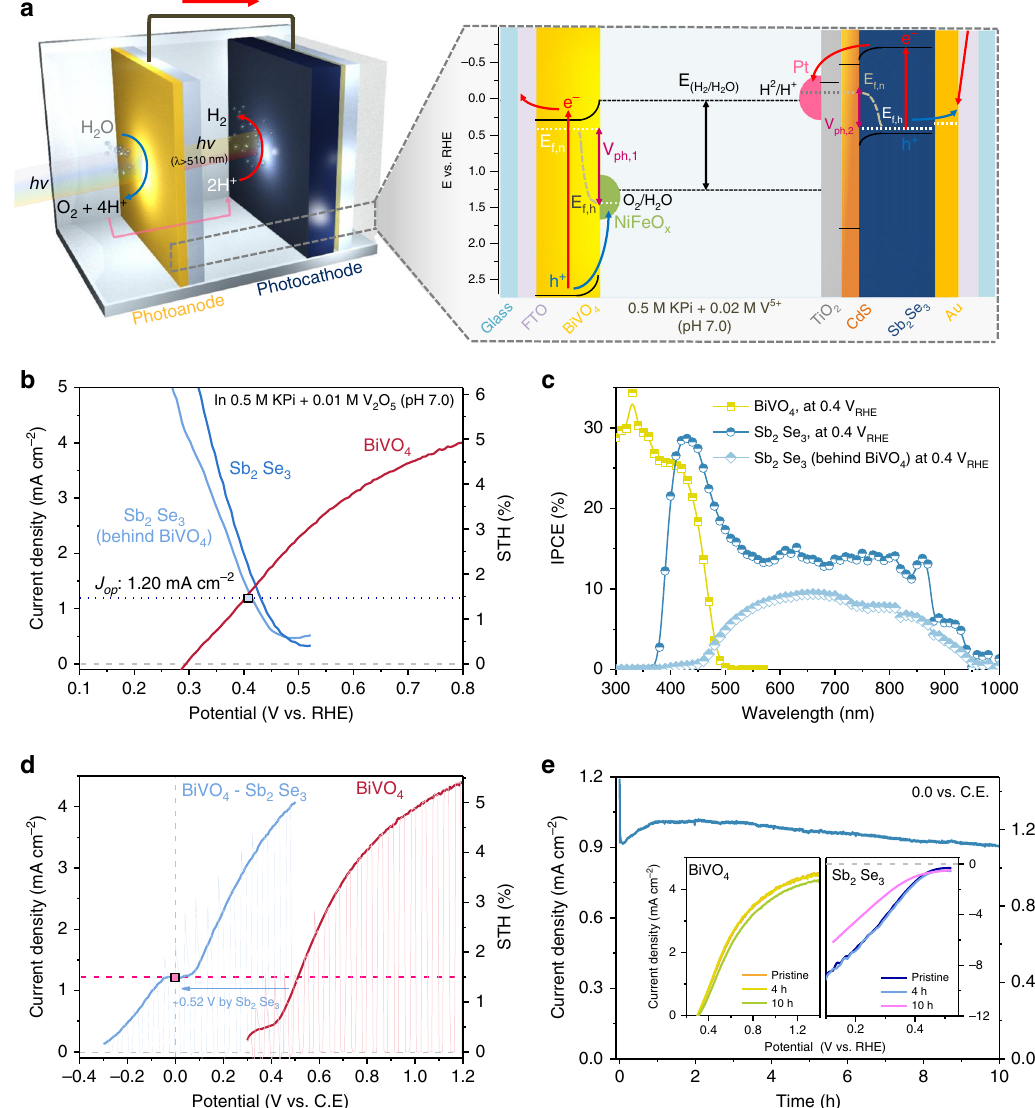
Fig. 5 Sb 3 Se 3 photocathode – BiVO 4 photoanode for solar overall water splitting PEC cell. a Scheme of the NiFeO x /H,Mo:BiVO 4 /FTO – Pt/TiO 2 /CdS/ Sb 2 Se 3 /Au/FTO tandem cell operating in pH 7.0 phosphate buffer. b J – V curve for the photocathode and photoanode; the operating point is marked for the tandem cell (photoelectrode active area: 0.32cm 2 ). c Two-electrode measurements for photoanode – counter electrode (C. E.) and photoanode – photocathode tandem cells (active area: 0.28cm 2 ). d IPCE at 0.4V RHE measured for the photoanode and photocathodes. e Photocurrent generation under short circuit conditions (0 against counter electrode) of the photoanode – photocathode tandem cell. All analyses were conducted in 0.5M phosphate buffer + 0.01M V 2 O 5 (pH 7.0) at a scan rate of 20mVs − 1 . Distance between the photoanode and photocathode was ~0.5cm. Source data used to generate this fi gure can be found in the Source Data fi